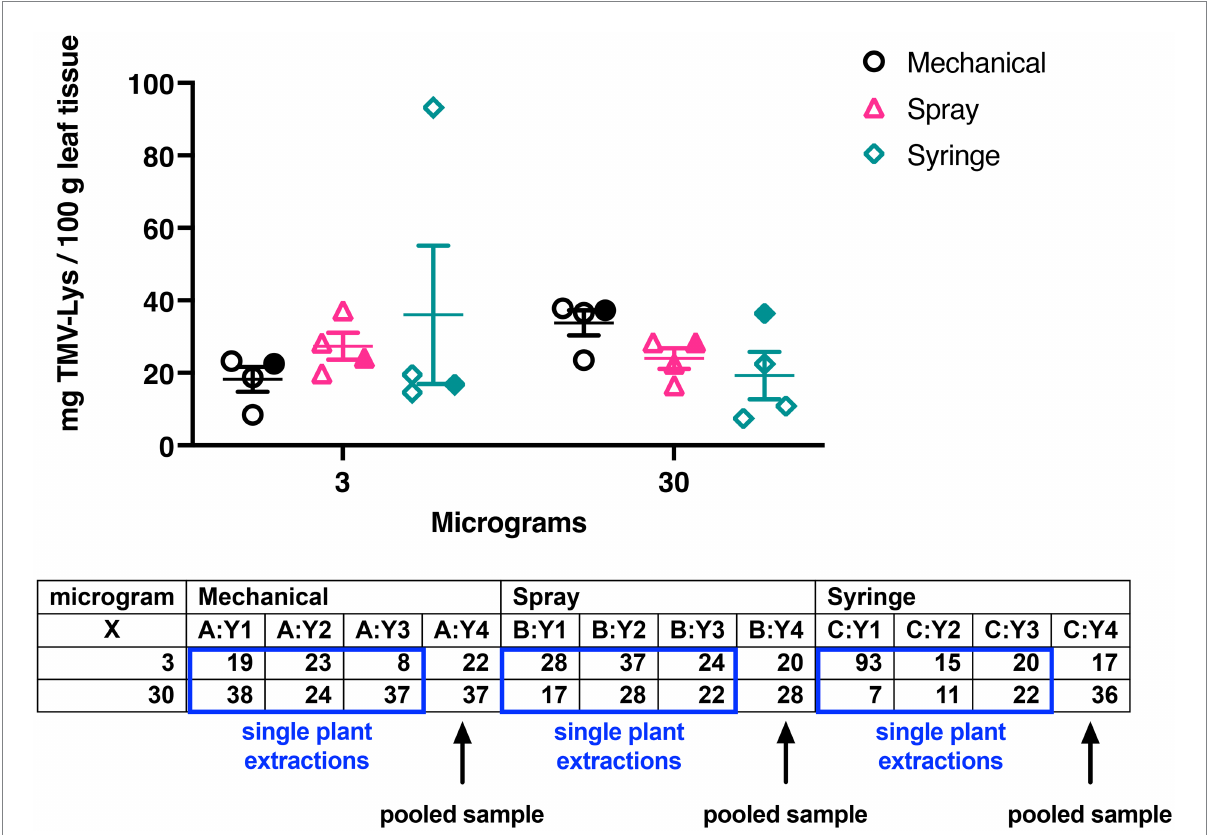
FIGURE 6 Graph and table showing the yields of TMV-Lys by the different inoculation methods (mechanical, spray, syringe) using 3 or 30 μ g of the plant virus. For groups Y1, Y2, and Y3 the data was obtained by extracting TMV-Lys from a single plant (open symbols) – the yields were normalized to 100 grams of leaves for comparison with pooled samples (Y4, filled symbols). Group Y4 are yields from pooled leaves from 10 plants. Data is in good agreement regardless of the sample